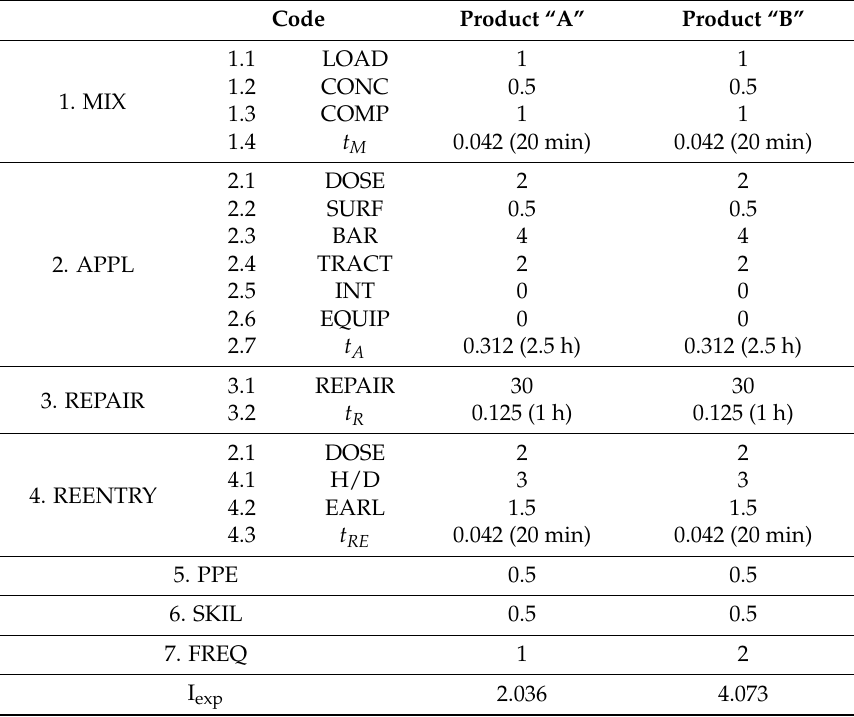
Table 12. Scores related to the calculation of the possible exposure